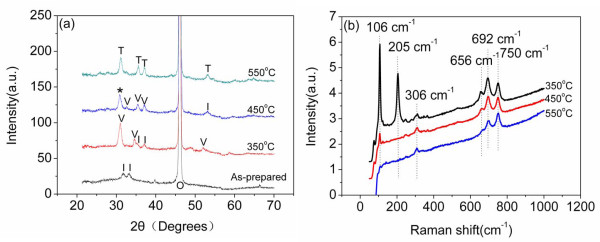
XRD patterns Raman spectra of SnOx nanopore films. (a) XRD patterns of the as-prepared sample and SnOx formed at varying oxidation temperatures of 350°C, 450°C, and 550°C. The symbol (O) indicates the substrate (Al2O3) reflections. The phases detected in the film are indicated as follows: I = Sn; V = SnO; asterisk = Sn2O3; T = SnO2. (b) Evolution of the Raman spectra of SnOx nanopore films prepared at 350°C, 450°C, and 550°C.